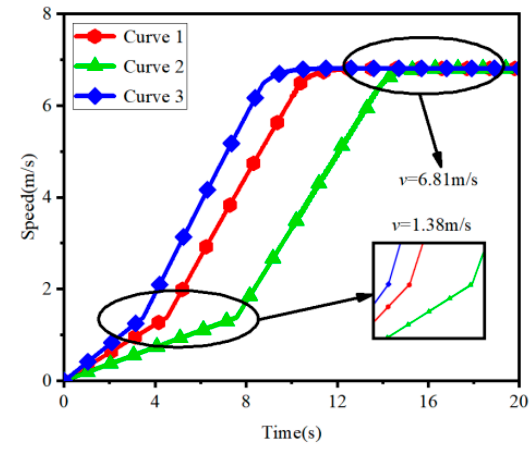
Figure 12. Diagram of the vehicle speed under different controls.